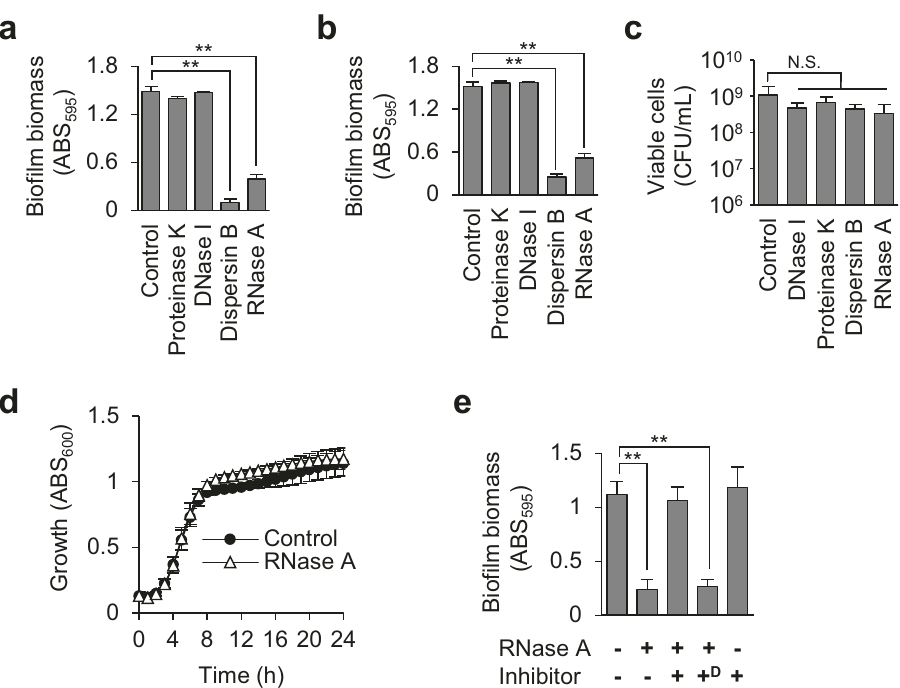
Fig. 1 Extracellular RNA maintains bio fi lm structural scaffolds. a Staphylococcus aureus MR10 24-h bio fi lms were treated with the indicated enzymes for 30 min at 37 °C or left untreated (Control). b MR10 bio fi lms were formed in the absence (Control) or presence of the indicated enzymes for 24 h at 37 °C. c The numbers of viable cells in the 24-h bio fi lms formed in the absence (Control) or presence of the indicated enzymes were counted as colony-forming units (CFUs) per 1mL. d The growth of MR10 was measured in BHIN with or without RNase A (80 μ g/mL) in a 96-well plate under static conditions. The absorbance of each well at 600nm was measured with an incubation reader (Scinics Corporation, Tokyo, Japan). e MR10 24-h bio fi lms were treated or not with RNase A. RNase inhibitor was added ( + ). In addition, the RNase inhibitor was denatured at 105°C for 5min and then added ( + D ). Bio fi lm biomasses are presented as the mean and standard deviation (error bar) of three independent experiments. ** P < 0.01. N.S. not signi fi